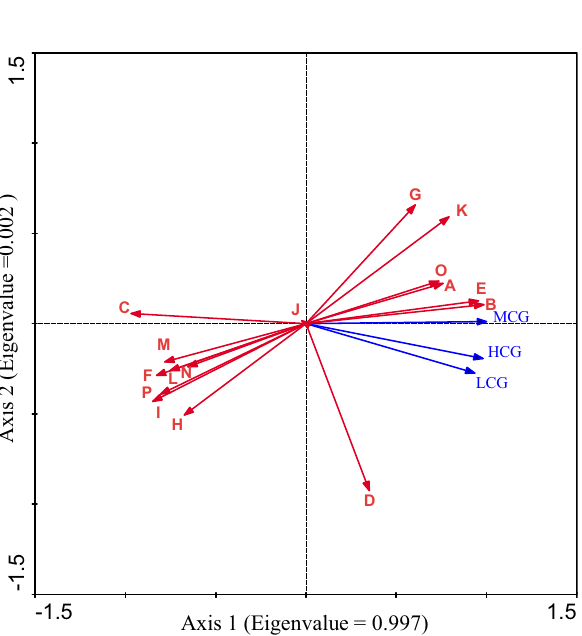
Figure 4. The correlation between the grassland coverage area and land use status classification. HCG = High- coverage grassland area, MCG = Medium-coverage grassland area, LCG = Low-coverage grassland area, A = Paddy field, B = Dry land, C = Forest land, D = Shrub forest land, E = Sparse forest land, F = Other forest land, G = Rivers, H = Lakes, I = Reservoirs and ponds, J = Tidal flats, K = Beach land, L = Towns, M = Rural residential land, N = Industrial and construction land, O = Bare land, P = Bare rock and gravel